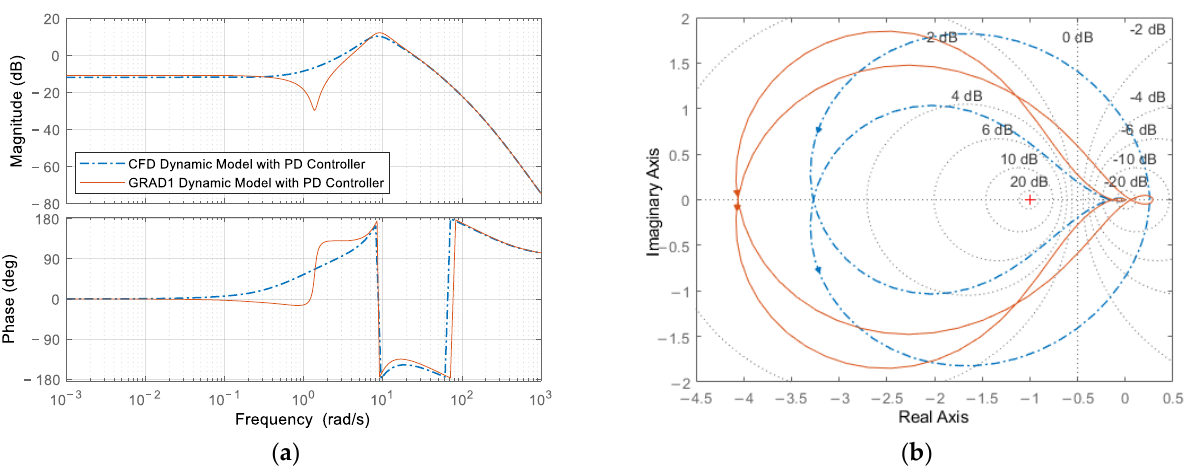
Figure 8. Frequency responses of extended dynamic models with a PD controller: ( a ) Bode plot; ( b ) Nyquist diagram.